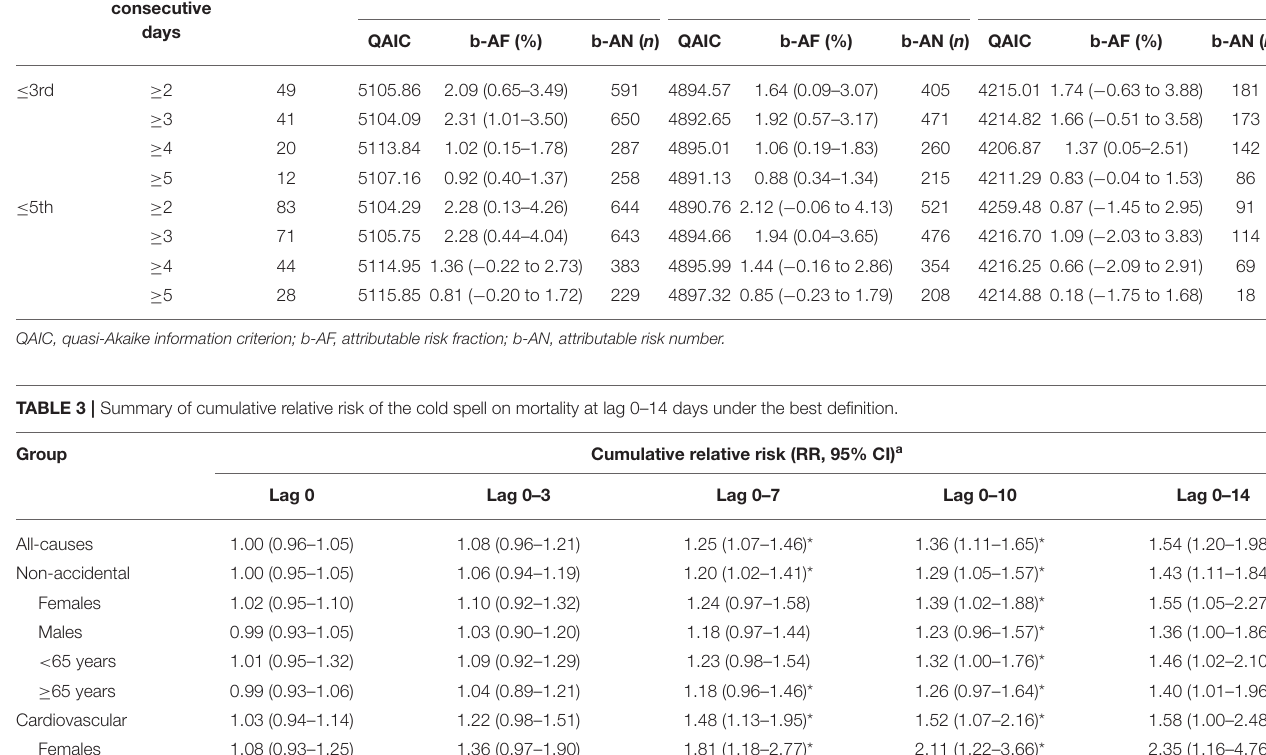
TABLE 2 | The QAIC value, attributable risk fraction, and attributable risk number calculated in the model under the eight different definitions of the cold spell. Percentile